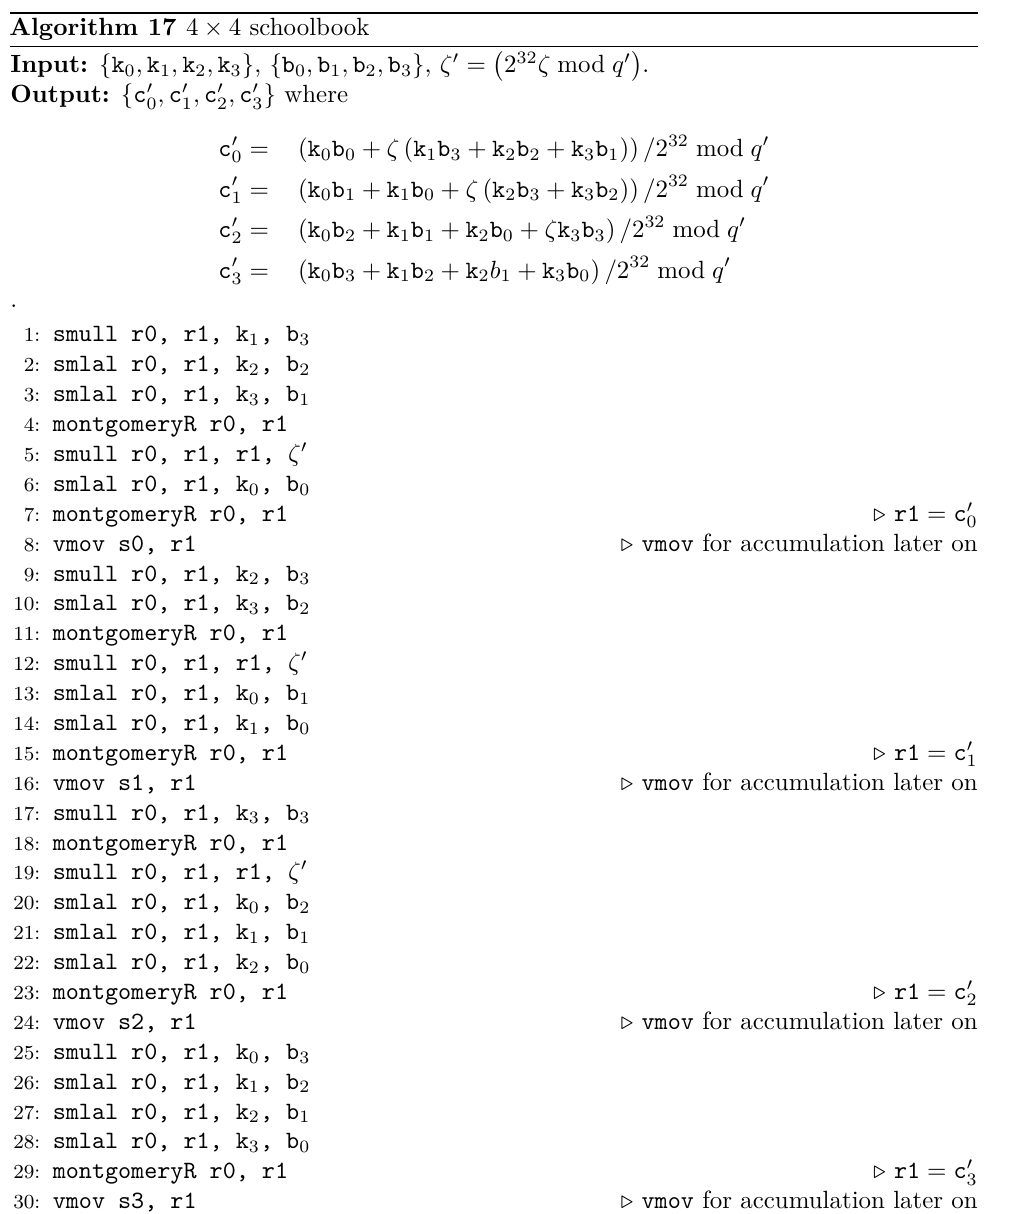
Algorithm 17 4 × 4